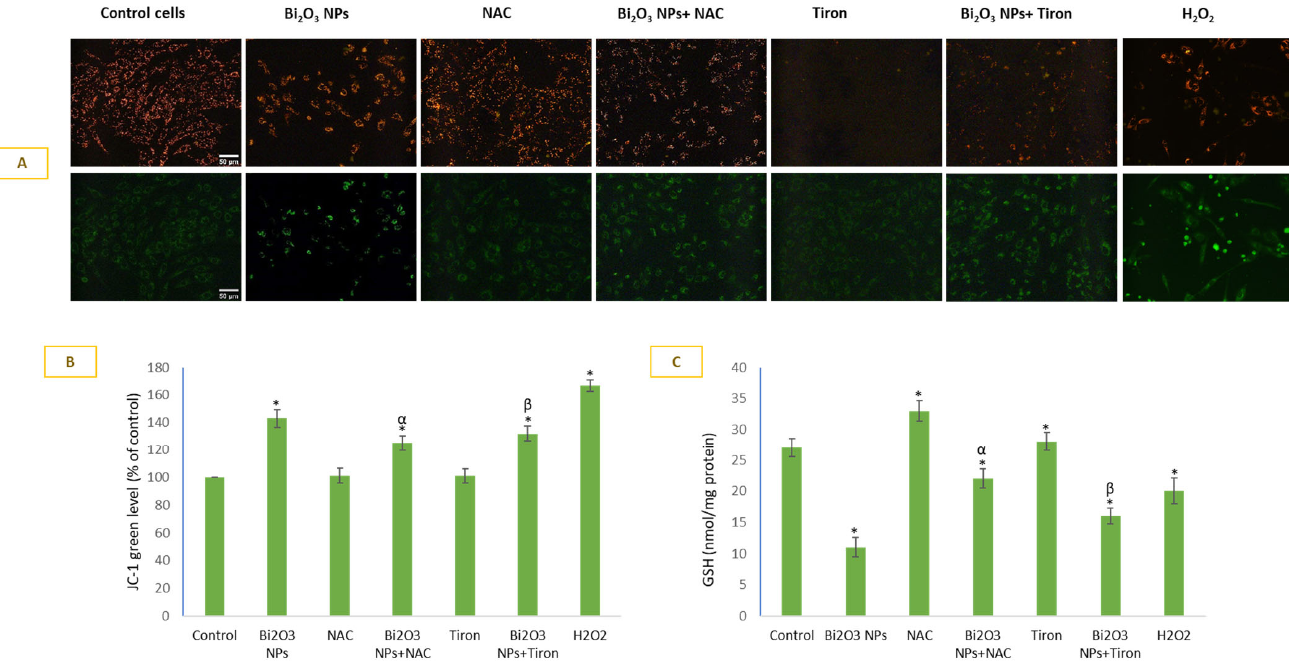
Figure 5. MMP was detected by JC-1 imaging in cells ( A ) and plotting green JC-1 fluorescence ( B ) in which green fluorescence is directly proportional to loss of MMP. Antioxidant GSH was also evaluated under various treatment conditions ( C ). Data represented are mean ± SD of three identical experiments ( n = 3) conducted in triplicate. * Statistically signi fi cant di ff erence compared to the controls ( p < 0.05). Any signi fi cant ( p < 0.05) di ff erence in response from that mediated by NPs and the addition of either NAC or Tiron is denoted by α and β , respectively.